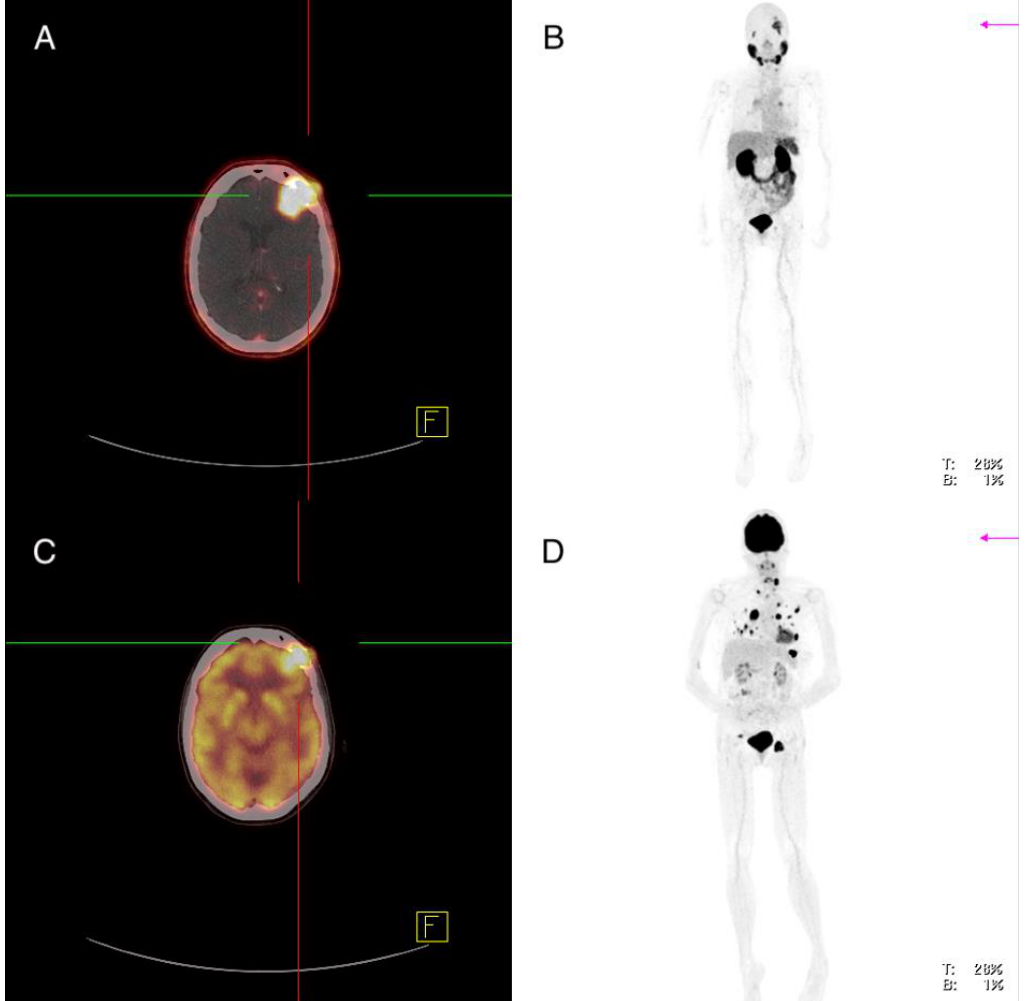
Figure 3. Patient 7: 68 Ga-PSMA-PET/CT ( A , B ), 18 FDG-PET/CT ( C , D ). A cerebral metastasis left frontal shows increased PSMA expression in concordance to an increased FDG uptake.